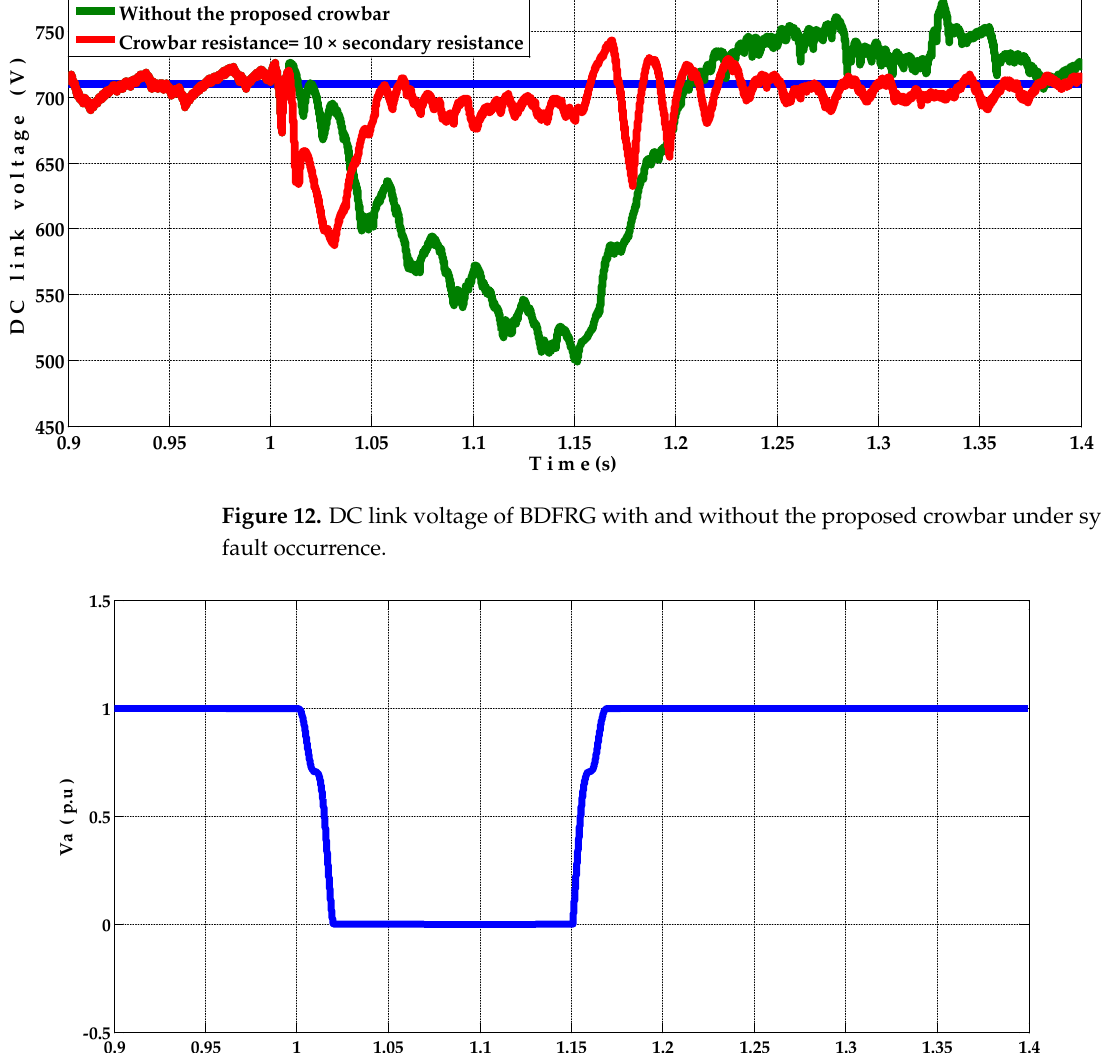
Figure 13. Per unit rms terminal voltage (Va) of the studied wind farm main coupling point under single-line to ground fault occurrence.